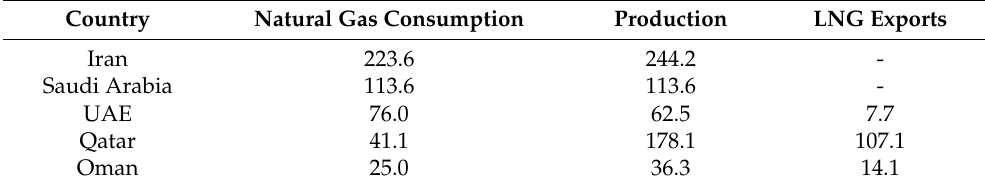
Table 2. Statistics of select countries in the Middle East region, Source: Data collected from [4], all quantities are in Billion cubic